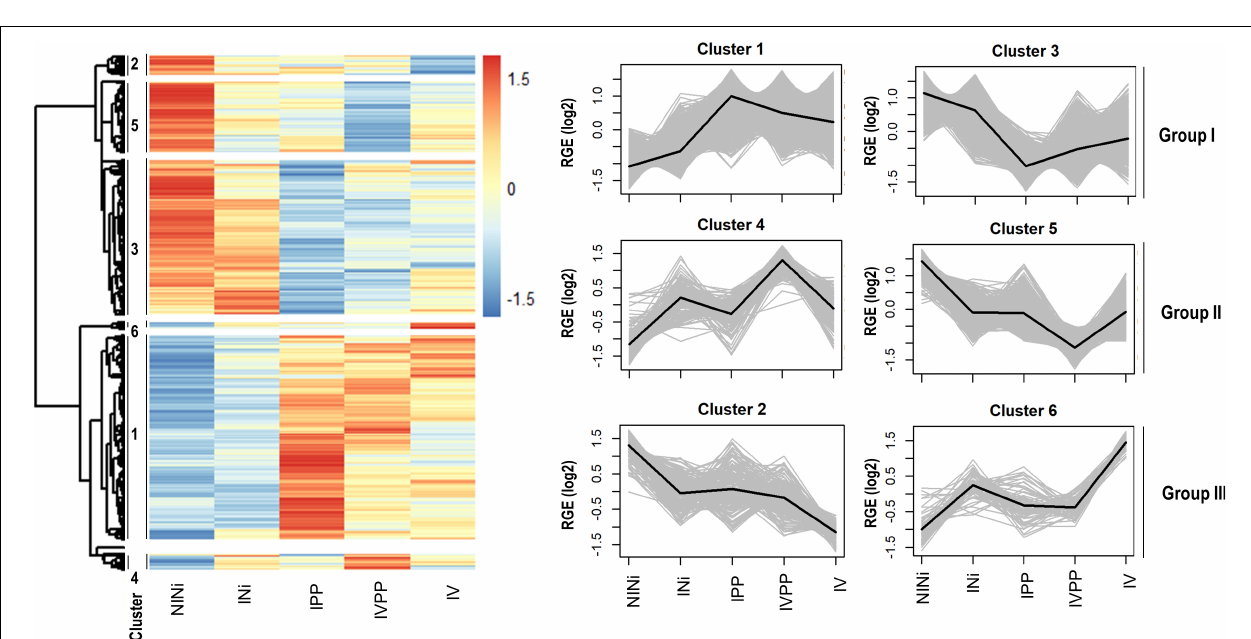
FIGURE 2 | Cluster analysis of the total DEGs associated to the different biotic stimuli. The heatmap shows the different gene expression patterns. Each line represents one gene, and each column represents a biological condition. The color key indicates log2 relative gene expression (RGE) values. The numbers on the left of the heatmap indicated the different clusters. DEGs were arranged in six different clusters depending on their pattern profile. Dendrograms represent the hierarchical distance between genes and clusters. On the right, the expression pattern for each cluster is showed. Clusters were rearranged in three groups: Clusters 1 and 3 (Group I), responding to the three biotic stimuli but specially to the infection; clusters 2 and 6 (Group III), responding to the BCA Vintec R (cid:13) ; and clusters 4 and 5 (Group II), responding to the infection and the BCA Vintec R (cid:13) .